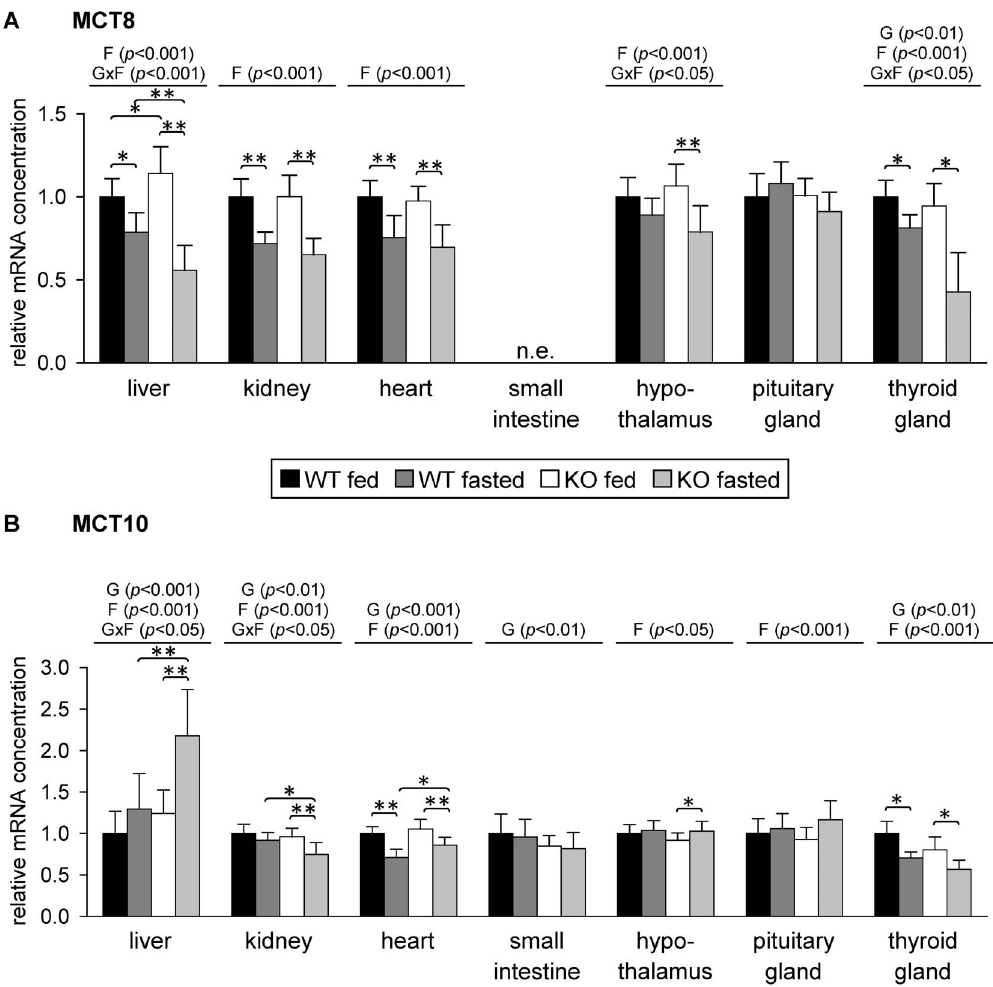
Figure 5. Relative mRNA concentration of (A) monocarboxylate transporter (MCT)-8 and (B) MCT10 in mouse tissues in response to fasting and PPAR a . Values represent means 6 SD of relative mRNA concentrations of wildtype (WT) and PPAR a knockout (KO) mice that were fed ad libitum or fasted for 48 h (n=16 for liver, kidney, heart, small intestine and hypothalamus, n=8 for pituitary gland, n=6 for thyroid gland). Data were analyzed by two-way ANOVA. Classification factors were genotype, fasting, and the interaction between both factors. P -values revealed by two- way ANOVA are noted above the figures. Individual means of the treatment groups were compared by Tukey’s test in case of variance homogeneity. In case of variance heterogeneity, as revealed by Levene’s test, individual means were compared by Games Howell test. Horizontal brackets represent differences between groups in post-hoc comparison (** p , 0.001, * p , 0.05). n.e., not evaluable due to extremely low expression.